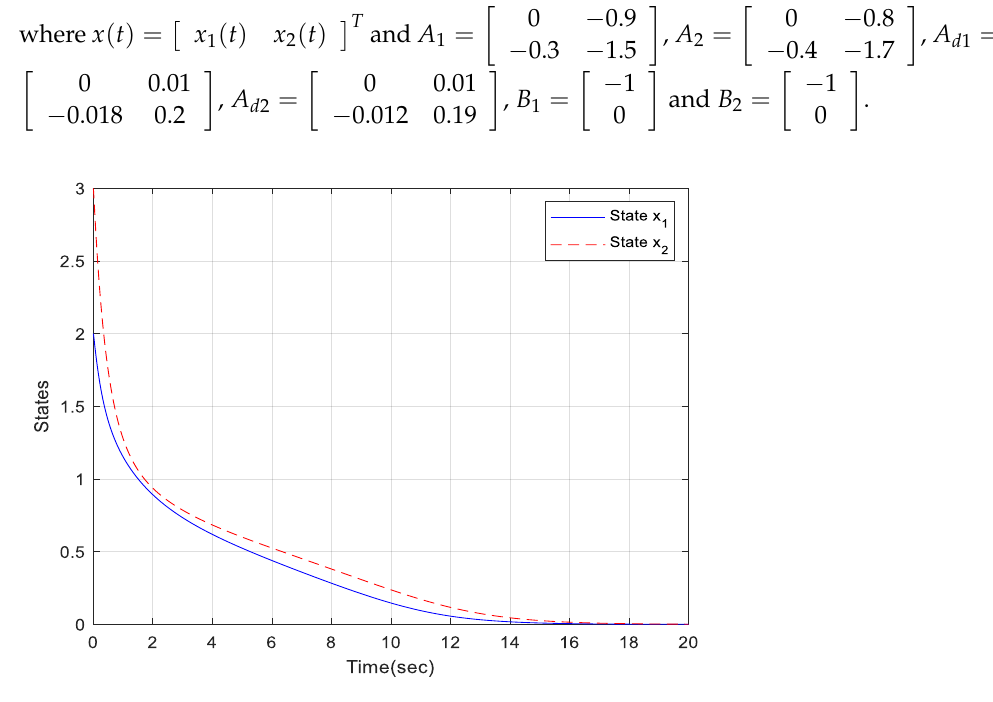
Figure 2. Trajectories for 𝑥 1 and 𝑥 2 .